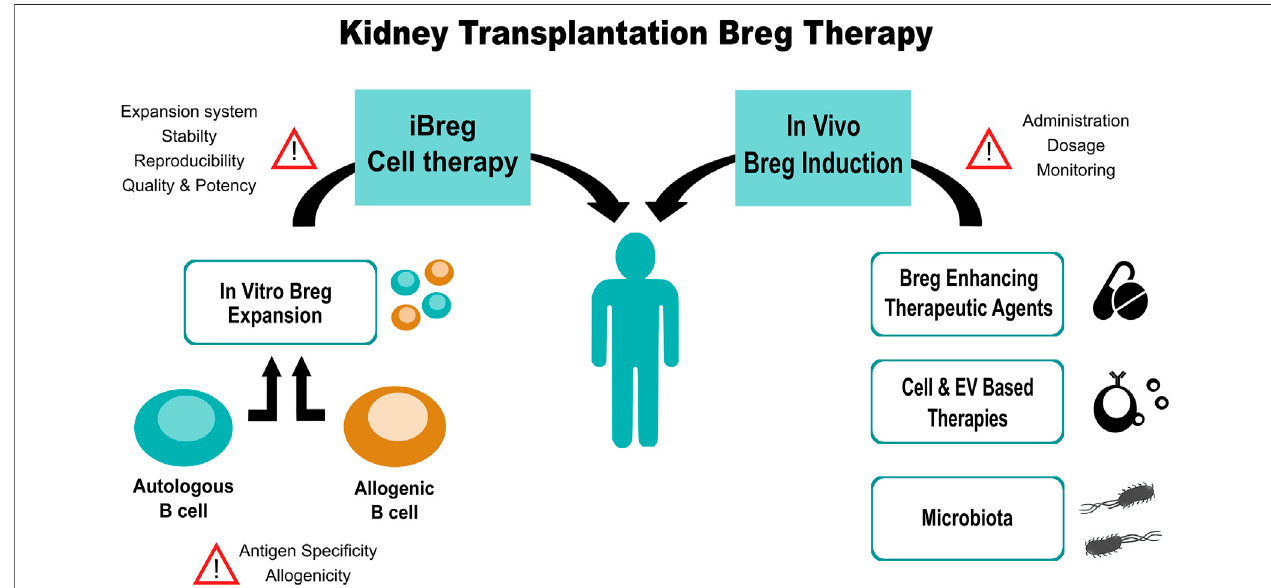
FIGURE 1 | Summarized work fl ow of Breg-based therapy for kidney transplanted patients, steps and points of concern.